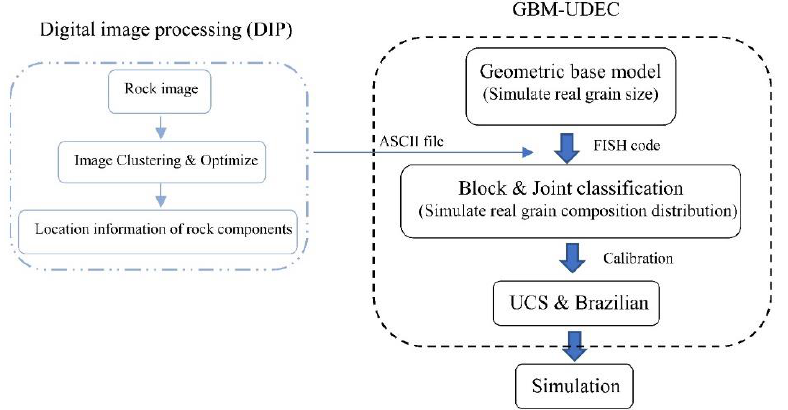
Figure 4. Flow chart of numerical model establishment and correction based on digital image pro- cessing.